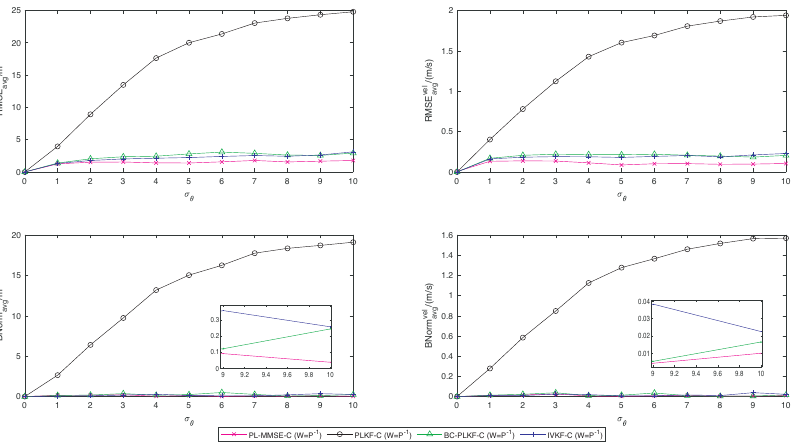
Figure 7. Time-averaged RMSEs, BNorms and bearing noise standard deviation for the four algo- rithms combined with the estimation projection method.